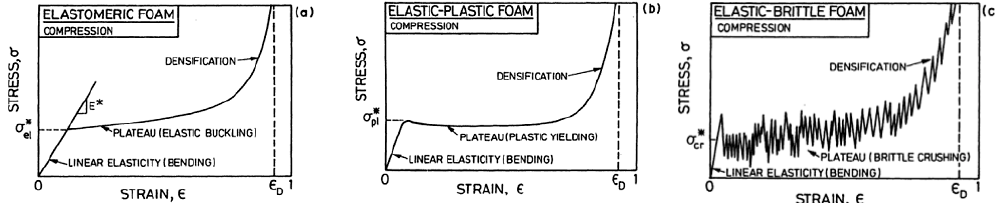
Figure 11. Schematic compressive stress-strain curves for foams showing the three regimes of linear elasticity, collapse and densification: ( a ) for an elastomeric foam; ( b ) for an elastic-plastic foam; ( c ) for an elastic-brittle foam.